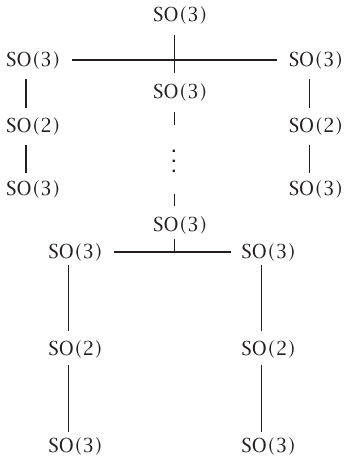
Figure 3.1. HB configuration manifold defined as an anthropomorphic product tree of the con- strained rotational Lie